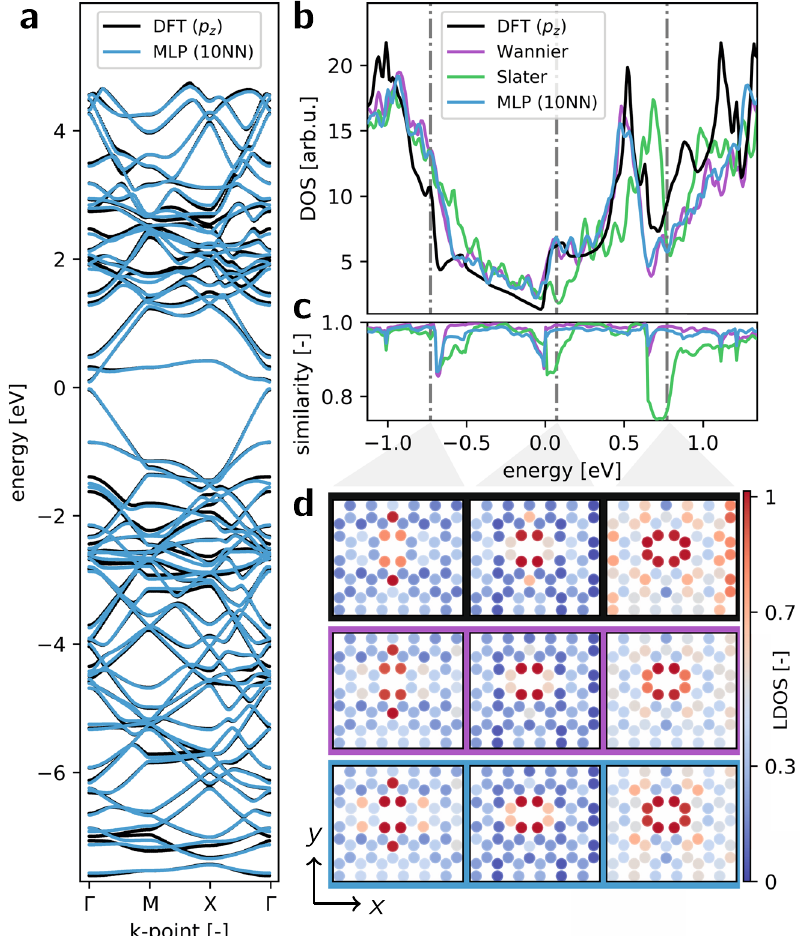
Fig. 5 Electronic structure analysis of vacancy defect. a BS of the SLG double vacancy supercell along Γ MX Γ of both DFT calculation and MLP TB-model. b p z -projected density of states of the supercell. c Cosine similarity of the local density of states between different TB models and the DFT result. d LDOS at the three energies (left to right) indicated by veritcal dash-dotted gray lines in b and c for DFT, Wannier, MLP respectively (top to bottom, colored boxes match line colors in b and c